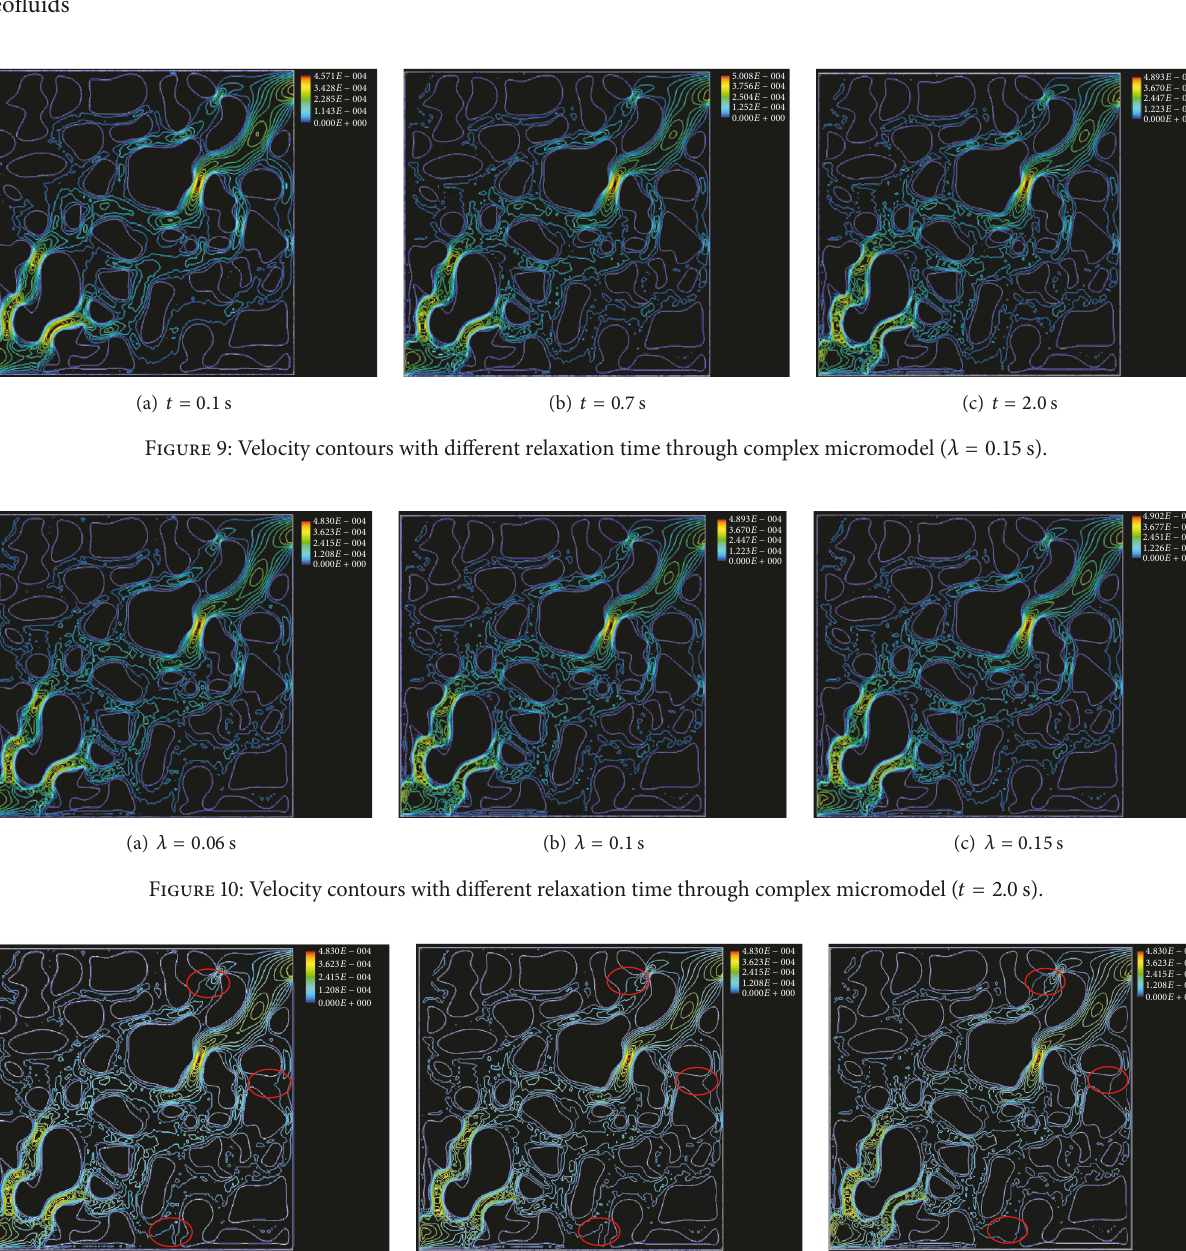
time increased. The microsweep efficiency increased as the elasticity